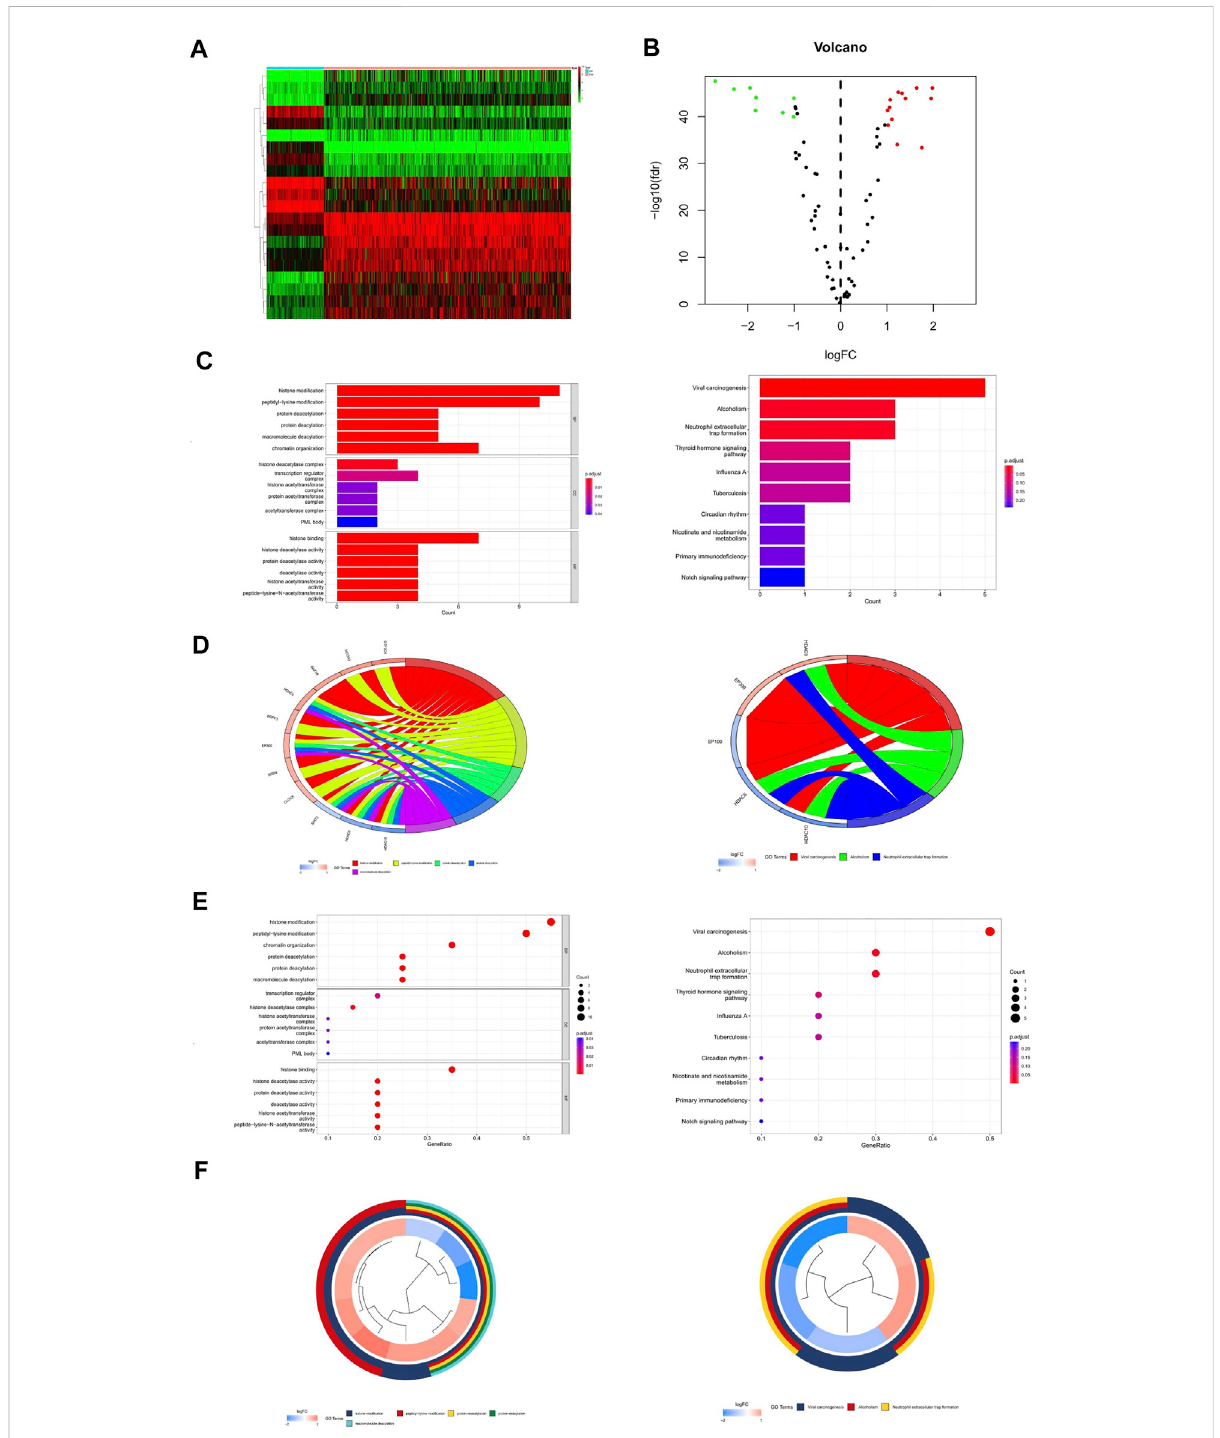
FIGURE 2 Differential expression analysis and gene enrichment analysis. (A) Heat map of differentially expressed genes. (B) Volcano map of differentially expressed genes. (C) Enrichment analysis histogram of GO and KEGG analysis. (D) Enrichment analysis bubble plot of GO and KEGG analysis. (E,F) Enrichment analysis circle diagram of GO and KEGG